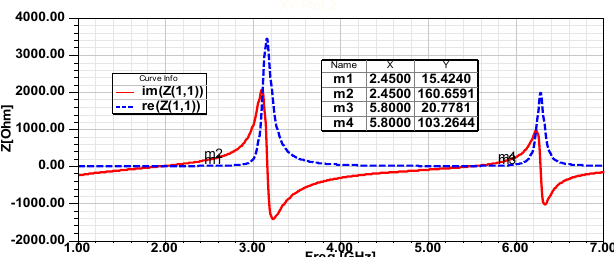
Fig. 2. Return loss S11 of initial antenna